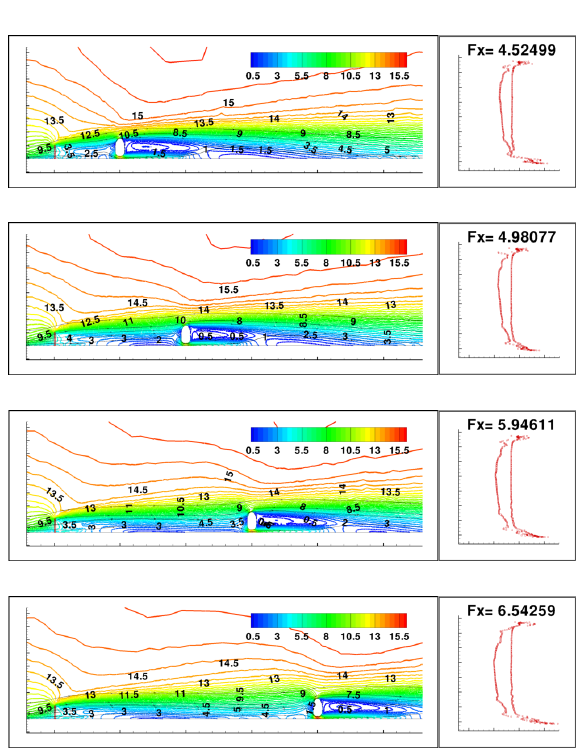
Fig. 5. CFD simulations of the flow through the barrier, regime 1570 the force acting on the body in the distance 5 H ,10 H ,15 H ,20 H behind the barrier with porosity 30% and height H .